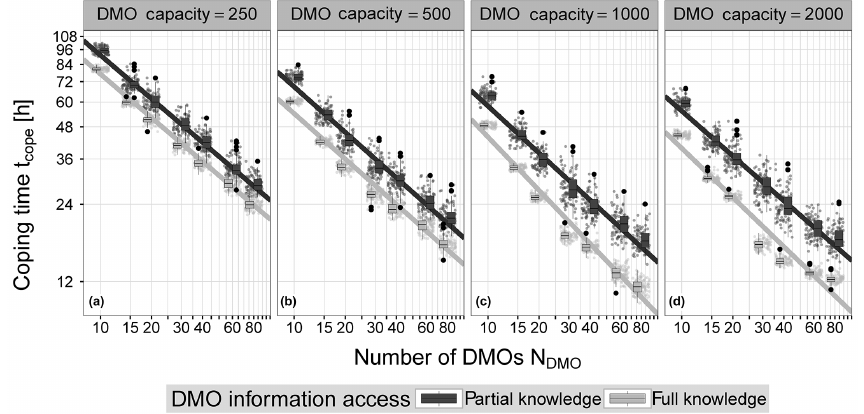
Figure 6. The distribution of coping time depending on DMO properties: (i) DMO transportation capacity (panels a – d ), (ii) the number of DMOs ( x axis) and (iii) their information access (dark grey/light grey). Dots represent results of single simulations, where overlapping dots result in darker colors and superimposed box plots show the distribution of the results. Thick line shows the fitted power law. Results are presented on a double logarithmic scale. Results correspond to a flood setting of 80 disaster sites and a total demand of 50000